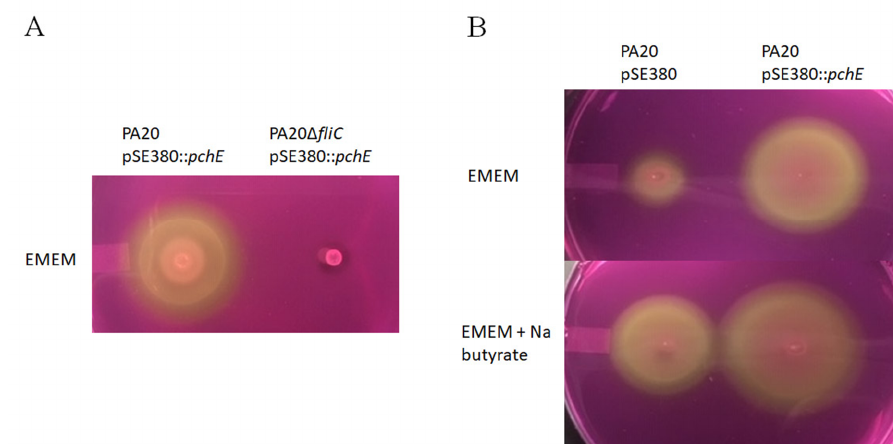
Figure 2. Strain swimming motility in EMEM soft agar incubated for 11 h at 37 °C. ( A ) Comparison of strains PA20 pSE380 (PA20), PA20  pchE (  pchE ) , and PA20 pSE380:: pchE (+ pchE ) spotted on soft agar. ( B ) Comparison of strains PA20, PA20  fliC (  fliC ), PA20  csgBA (  csgBA ), and PA20  csgD (  csg D ) spotted on soft agar.